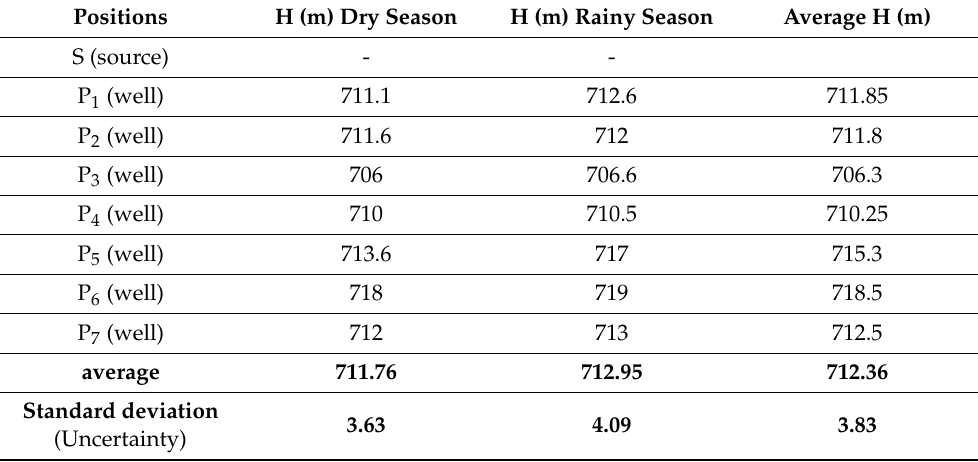
Table 2. Results of the piezometric levels (Uncertainty: ∓ 1